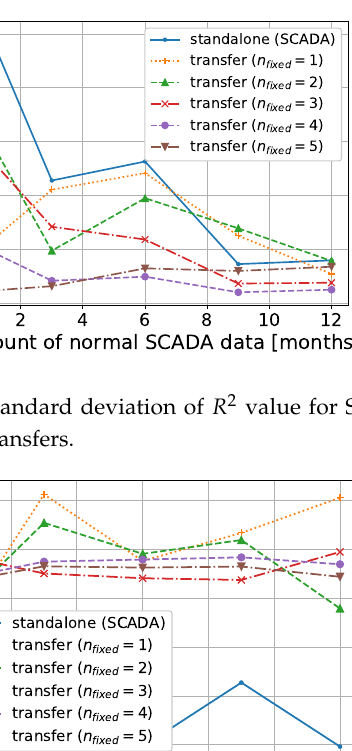
Figure 20. Average R 2 value for SDAE for different amounts of training data and knowledge transfers.